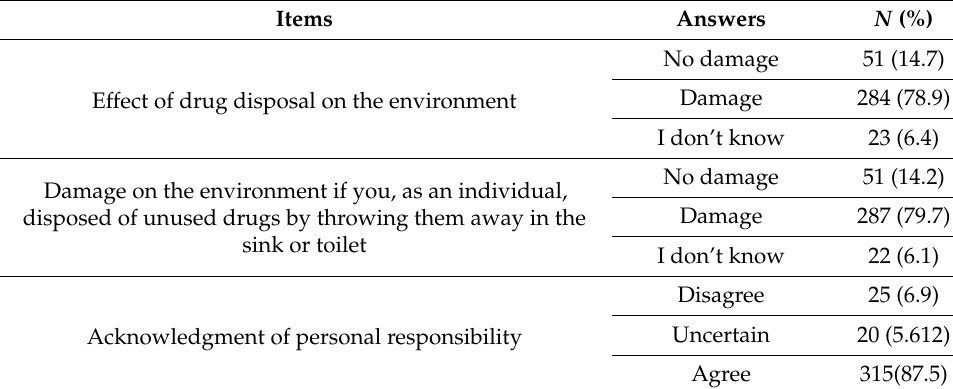
Table 3. Awareness among community pharmacists of environmental hazards of unused medica- tion disposal.